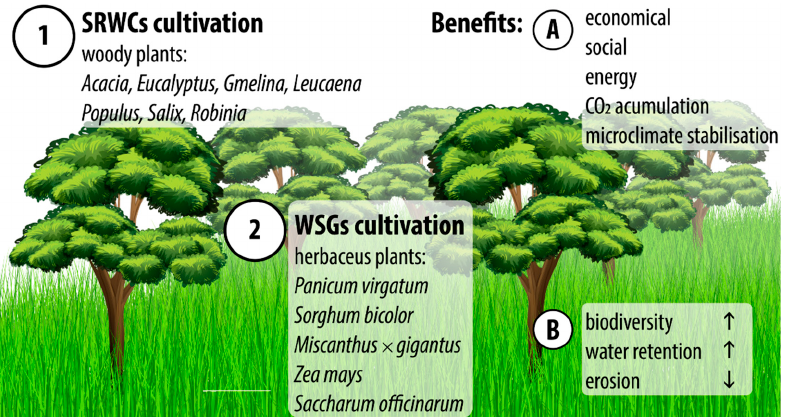
Figure 2. Benefits of lignocellulosic feed-stock cultivation on marginal soil. Some examples of frequently used (1) woody plants and (2) herbaceous plants, often used on arid marginal lands, which brings basic benefits from both ( a ) an utilitarian and ( b ) environmental point of view. Detailed explanation in text.